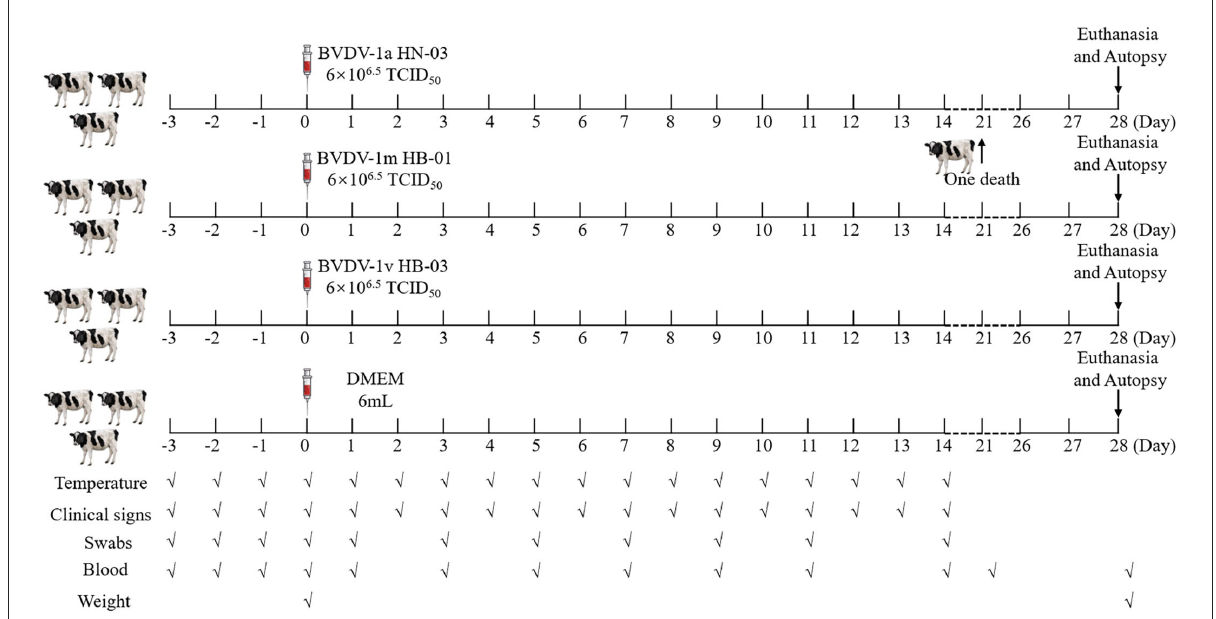
FIGURE1 The animal experiment protocol. Calves were intranasally infected with bovine viral diarrhea virus (BVDV). All animals were euthanized and necropsied at 28 dpi, except for one animal (BVDV-1a HN-03 group) that died at 21 dpi. The markers below indicate the measures and sample collection on the